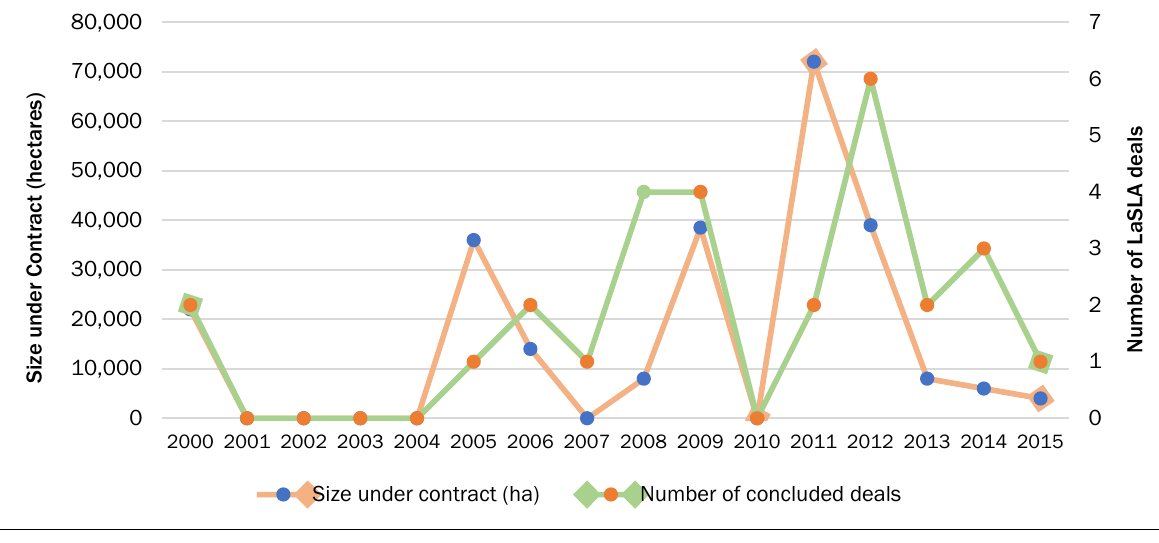
Data source: The Land Matrix